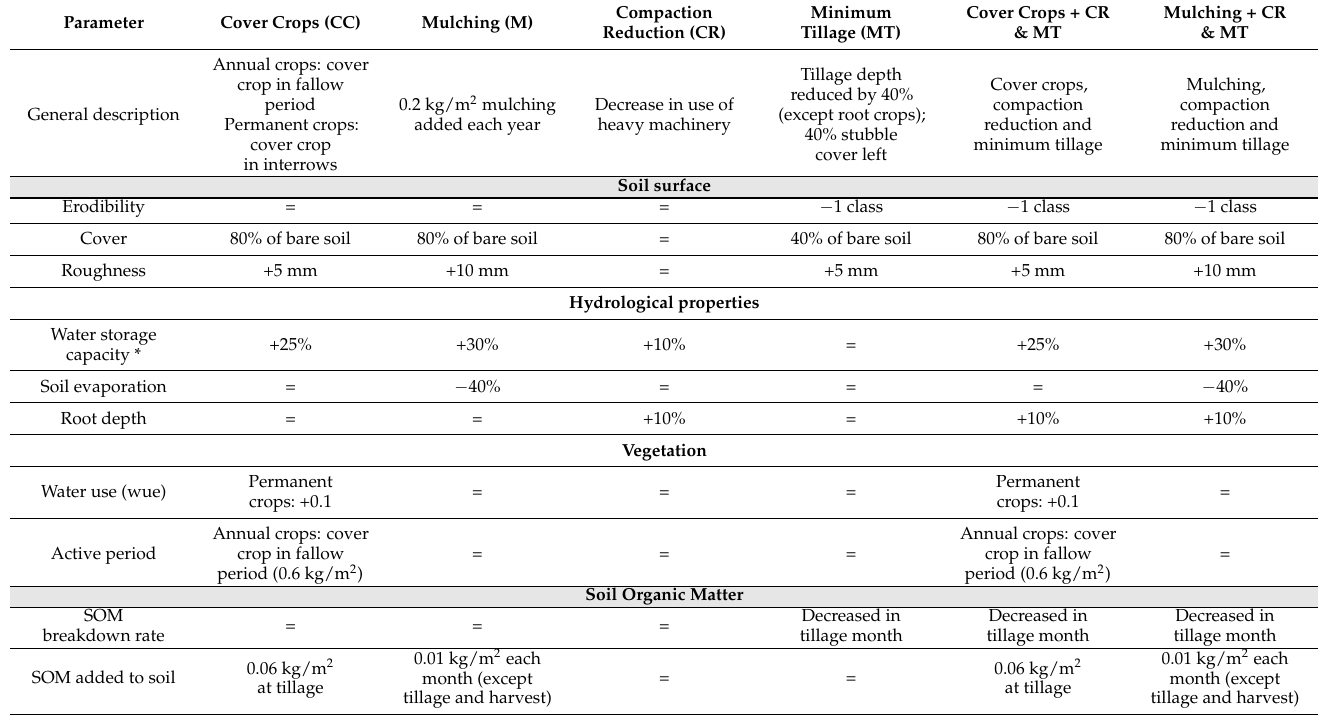
Table 3. Implementation of soil improving measures in